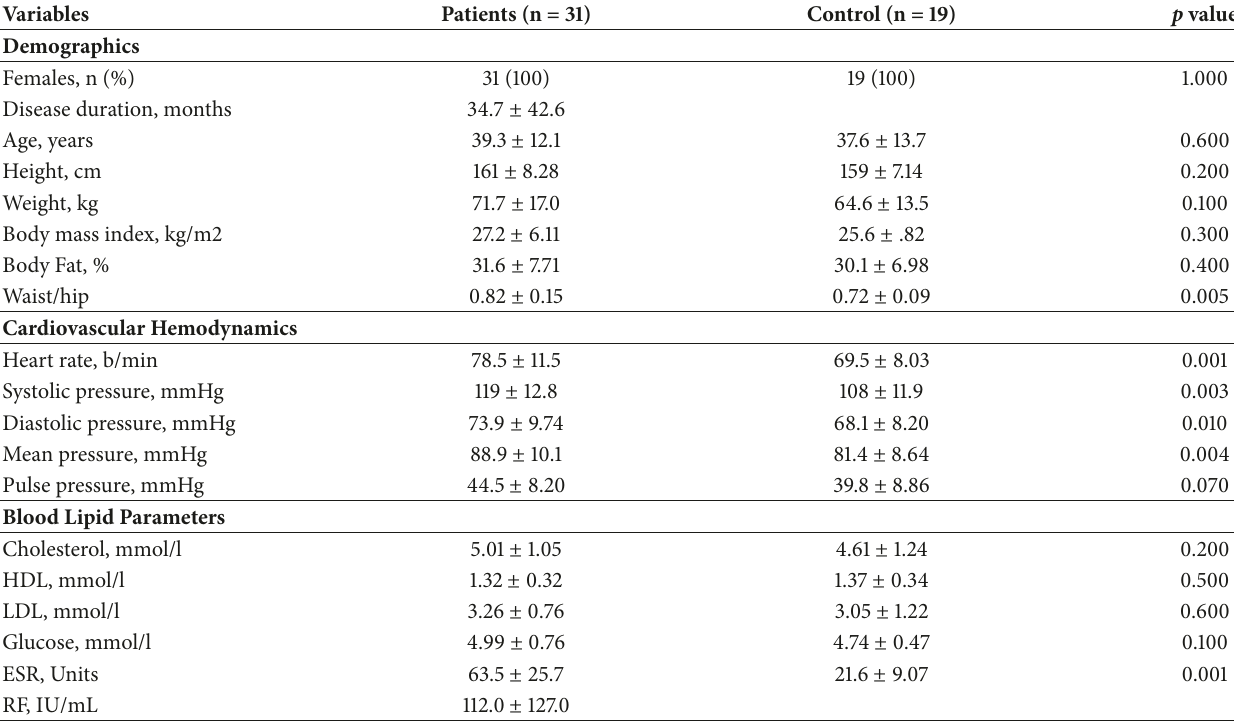
Table 1: Participant characteristics, cardiovascular hemodynamics, and blood lipid parameters.